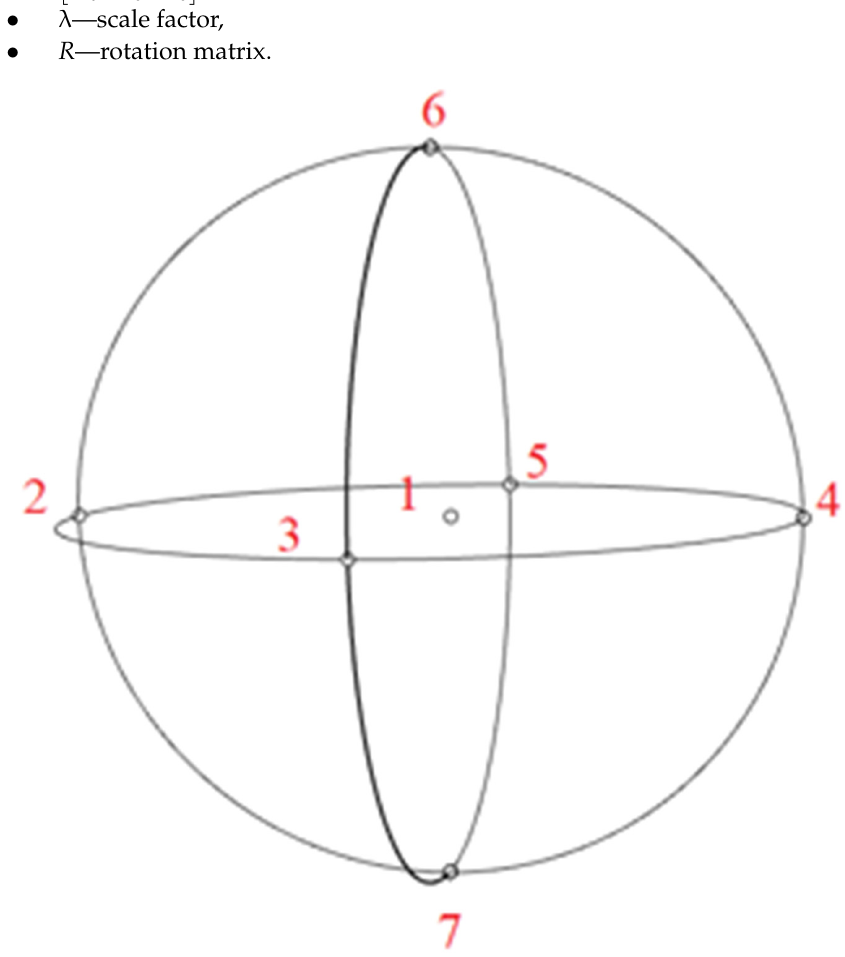
Figure 2. Reference points for generating a virtual point cloud (general